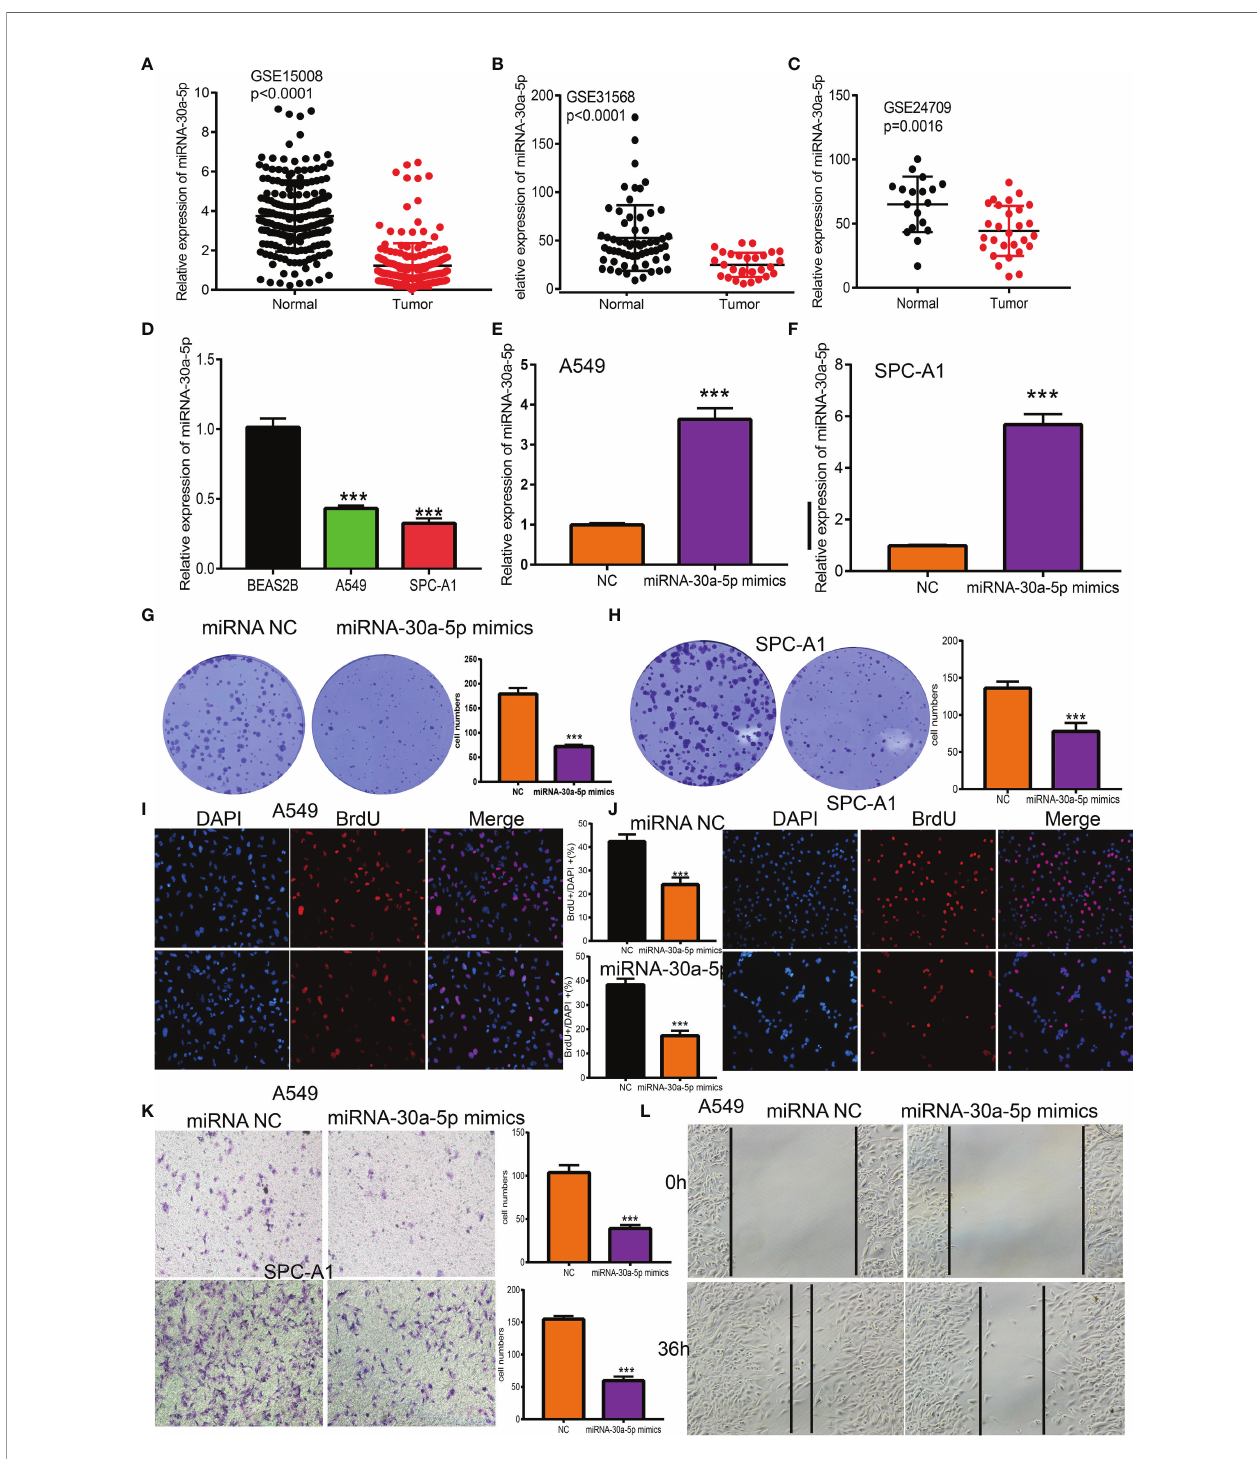
FIGURE 8 | Over-expression of miRNA-30a-5p inhibits the cell proliferation and migration ability of LUAD cells. (A – C) The expression of miRNA-30a-5p in LUAD was examined by GEO datasets. (D) The expression of miRNA-30a-5p in LUAD cell lines was examined by qRT-PCR assay. (E, F) The expression of miRNA-30a-5p in LUAD cells lines after over-expression of miRNA-30a-5p was examined by using the qRT-PCR assay. (G – J) Over-expression of miRNA-30a-5p on cell growth ability examined by clone information and BrdU assays. (K, L) Over-expression of miRNA-30a-5p on cell migration ability examined by transwell and wound healing assay. Quanti fi cation data were also indicated. Scale bar=50 mm. ***P <